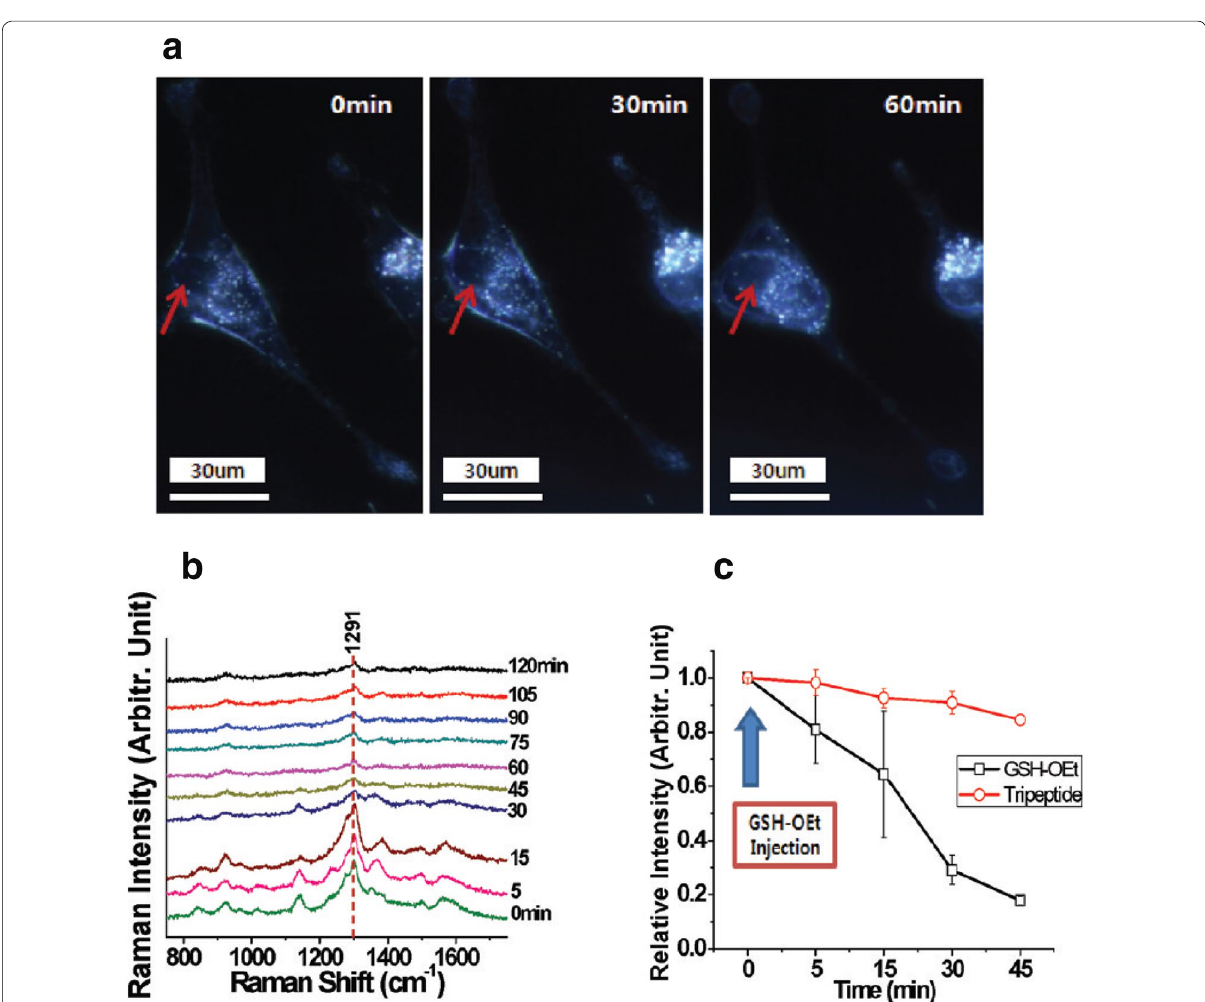
Fig. 11 a Time‑lapse DFM live cell images in a single HeLa cell after treatment of glutathione ethyl ester (GSH‑OEt) indicating the in situ release of 6TG from Au NPs. The arrow indicates the position where the Raman spectra were obtained. b The strongest peak at 1291 cm − 1 from 6TG was used. c Plot of decrease in the band intensities depending on the elapsed time after GSH‑OEt injection (Reprinted with permission from [101]. Copyright @ 2002 American Chemical